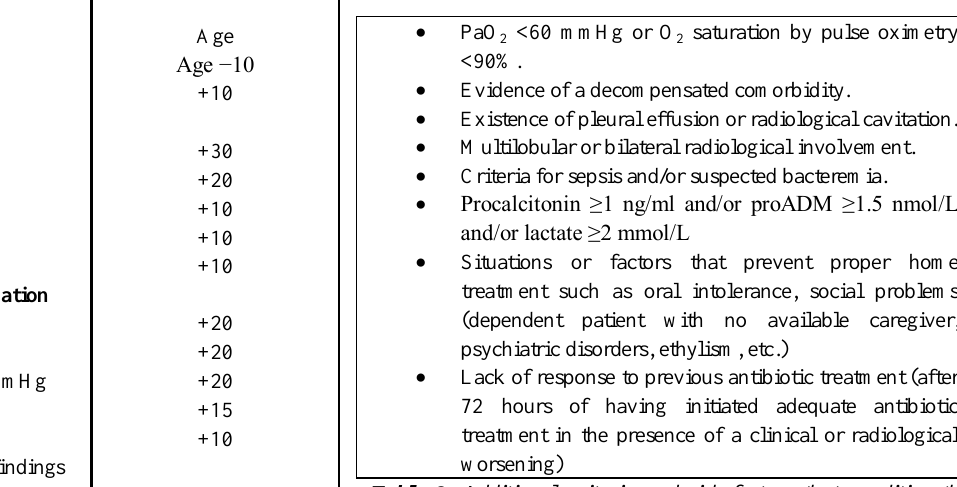
Table 8: Additional criteria and risk factors that condition the admission of patients with PSI I-III. PSI: Pneumonia severity index; PaO 2 : Partial arterial oxygen pressure; O: Oxygen; proADM: proadrenomedulin  C Confusion. Disorientation in time, space and person